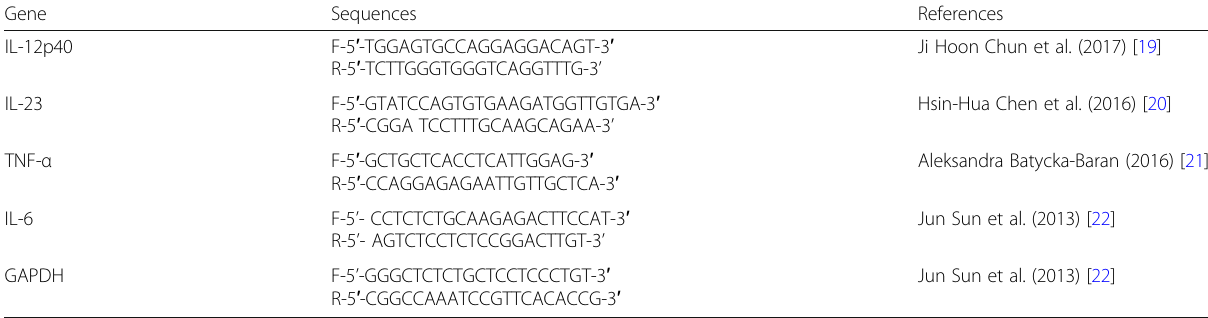
Table 1 Specific primers used for determination of mRNA expression of the pro-inflammatory genes Gene